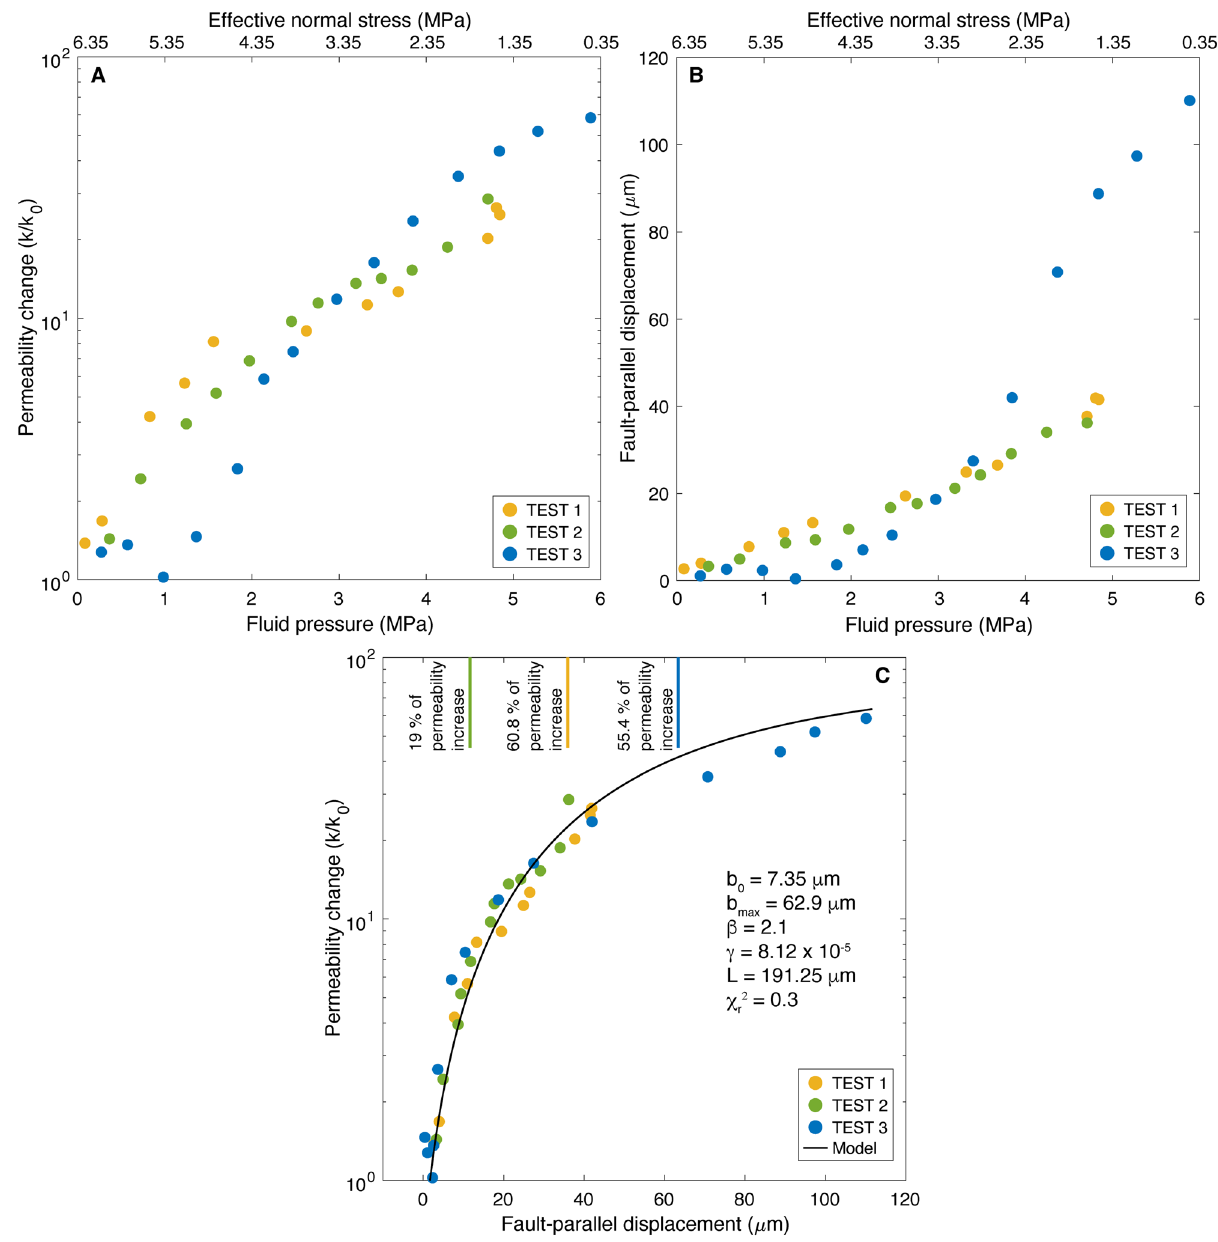
Fig. 3 Evolution of fault permeability during fl uid pressurization. A Permeability change ( k/k 0 ) and ( B ) fault-parallel displacement (i.e. “ cumulated slip ” ) as a function of effective normal stress and increasing fl uid pressure. C Permeability change ( k/k 0 ) versus cumulated fault-parallel displacement. The black line in ( C ) is the best- fi t modeling result obtained with Eqs. 1 and 2. The reference values for the parameters b 0 , b max , β , γ , L are indicated and allow to fi t in a single model the whole permeability evolution measured in the three tests. The vertical lines indicate the onset of seismicity and the percentage of permeability increase achieved during the aseismic slip period, respectively observed during Test 1 (orange), Test 2 (green), and Test 3